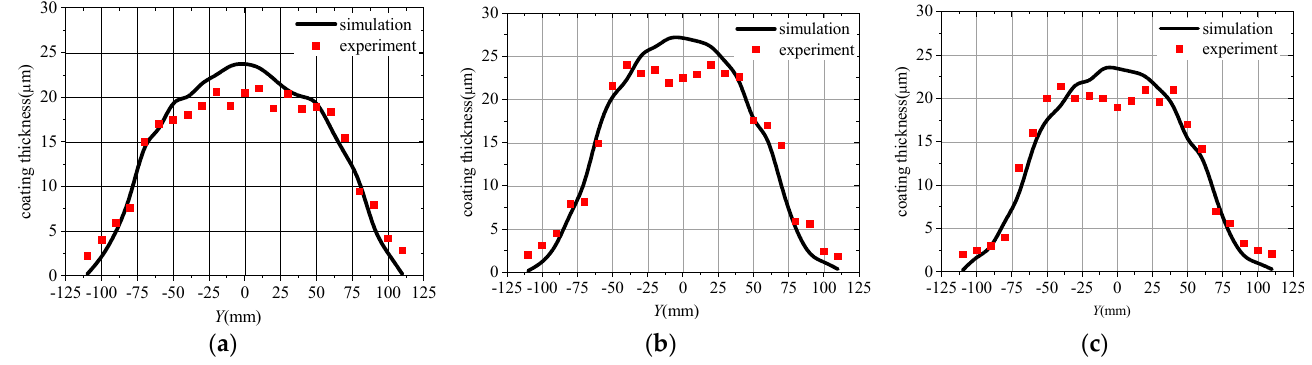
Figure 11. Comparison between the experimental and simulated coating thickness distributions on different sections of the surface with an angle of 90 degree. ( a ) section A; ( b ) section B; ( c ) section C.